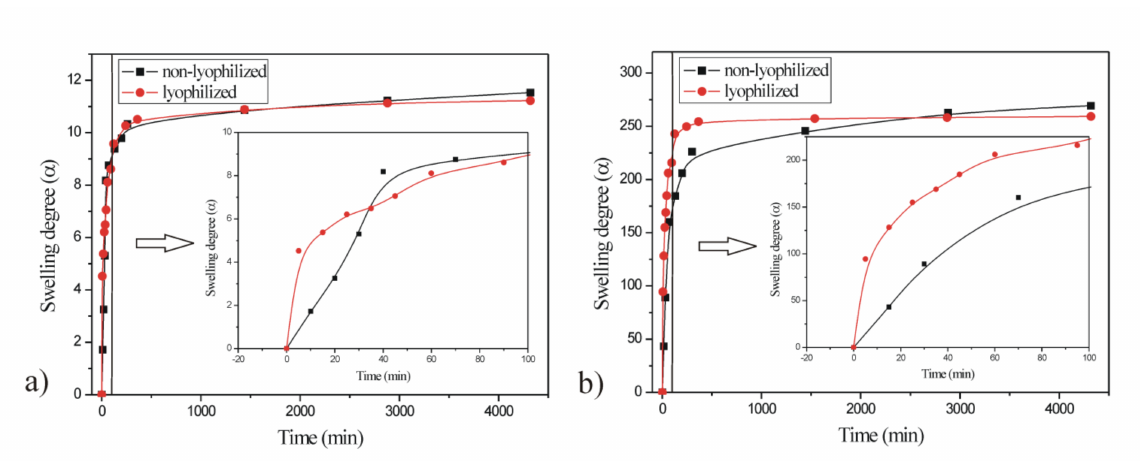
Figure 9. Dependence of the swelling degree of the p(NIPAM-co-AA) hydrogel before and after lyophilization on time at 25 ◦ C and ( a ) pH 3.5 and ( b )